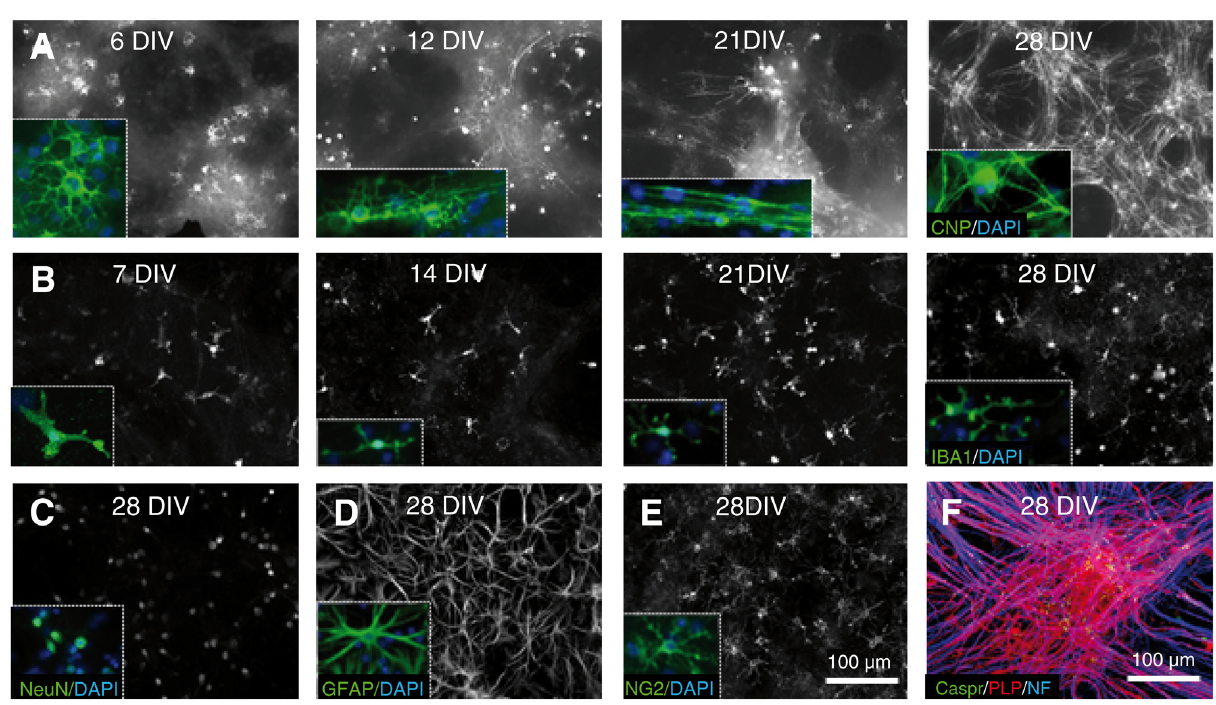
Figure 1. Embryonic day 13 mouse spinal cord cells differentiate over time into the major neural cell types of the nervous system. A . The morphology of CNP positive cells changes with time in culture. At 6 DIV, multiple cell process extend from the cell body and the cells have a ‘lacy’ appearance, as shown in the inset. By 12 DIV, a small number of myelin-like sheaths are present; often a single single sheath can be observed running in a line through one axis of an otherwise ‘lacy–appearing’ cell. In the inset, two such sheaths can be observed along 3 adjacent ‘lacy-appearing’ cells. By 21 DIV, many cells have extended multiple myelin-like sheaths and by 28 DIV few ‘lacy-appearing’ cells remain and a dense network of myelin sheaths are visible. When stained with antibodies to PLP/DM20, Caspr and phosphorylated neurofilament (NF), many axons are covered by consecutive sheaths with nodes of Ranvier straddled by Caspr positive paranodes (bottom right image). B . Iba1 +ve microglia are present at all stages examined. At 7DIV most microglia appear amoeboid but become ramified and extend multiple processes over time (insets). C . Antibody to NeuN labels neuronal nuclei and sometimes staining extends into the cytoplasm, but rarely enters the cell processes. D . GFAP positive astrocytes are found throughout the culture, ( E ) as are NG2 +ve OPCs. F .